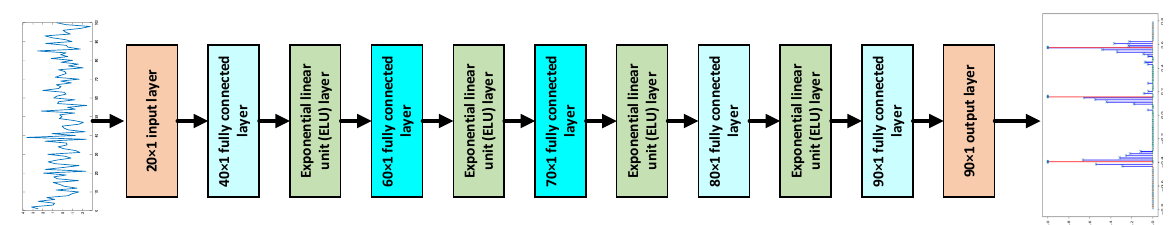
Figure 6. The model architecture for the atomic